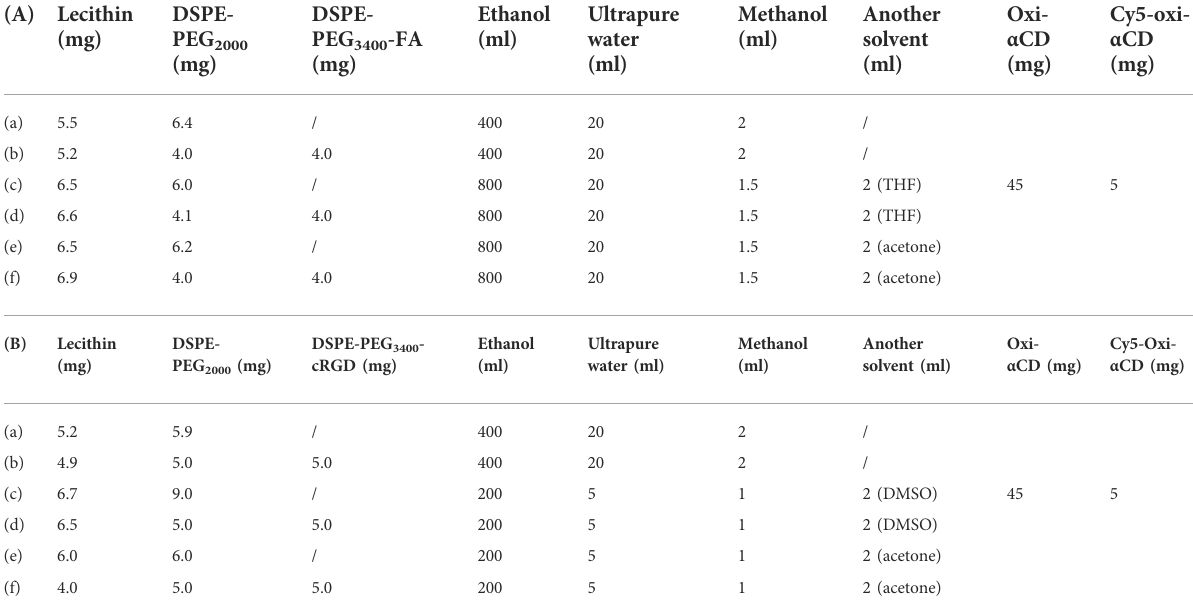
TABLE 1 Synthesis formula table of (A) (a, c, e) Cy5-labeled Oxi- α CD NPs and (b, d, f) Cy5-labeled FA-Oxi- α CD NPs; (B) (a, c, e) Cy5-labeled Oxi- α CD NPs and (b, d, f) Cy5-labeled cRGD-Oxi- α CD NPs.